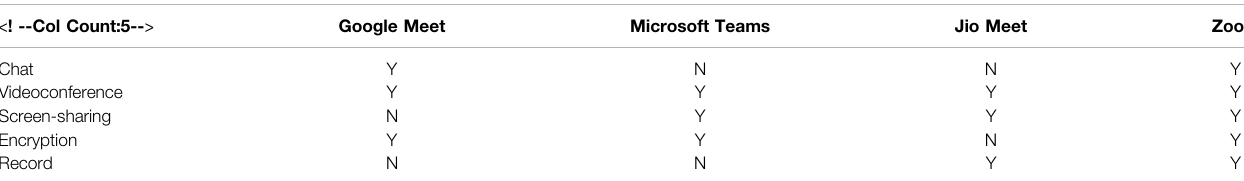
TABLE 1 | Open-source Web communication